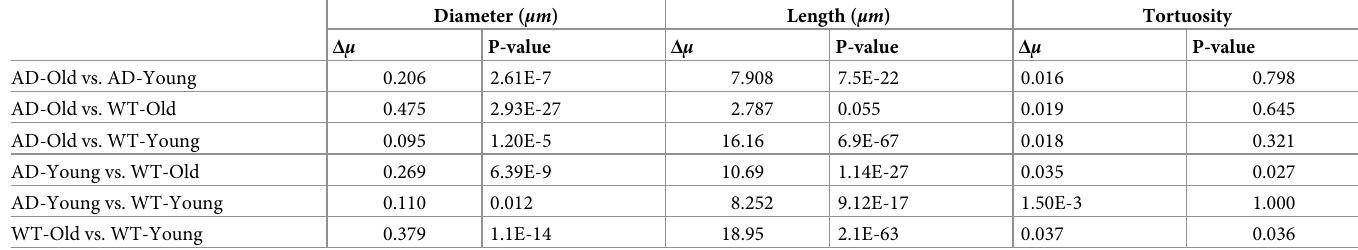
Table 2. Comparison between metrics distributions between different groups using Kruskal-Wallis test followed by Bonferroni multiple comparison correction. Δ μ is the difference between the mean values of the two tested groups.